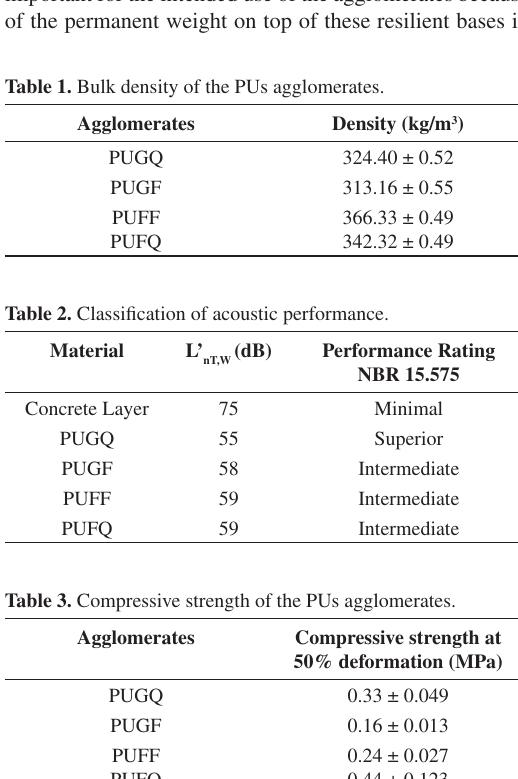
Figure 1. Sound pressure levels of standardized impact L